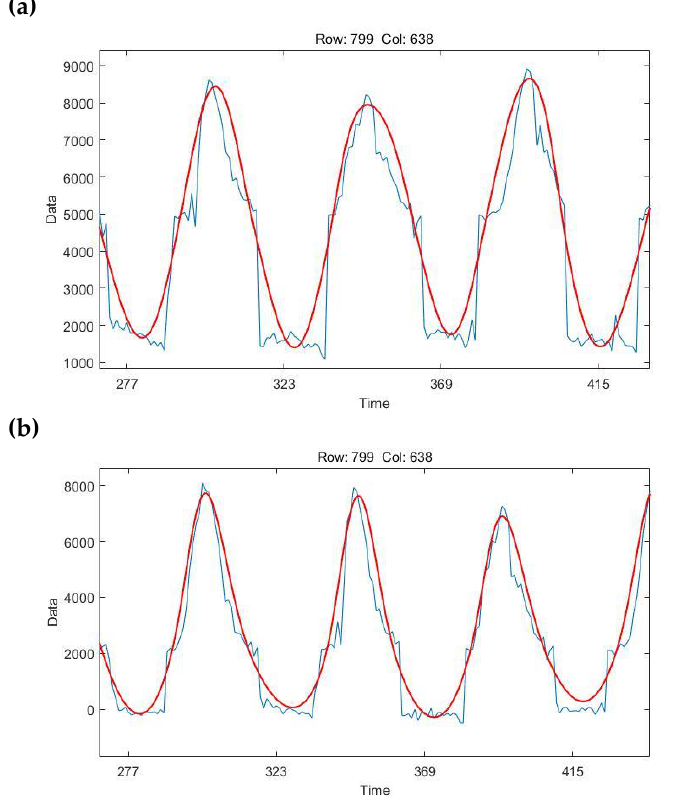
Figure 4. Time series reconstruction results under the double-logistic base normalized difference phenology index (NDPI) ( a ) and normalized difference vegetation index (NDVI) ( b